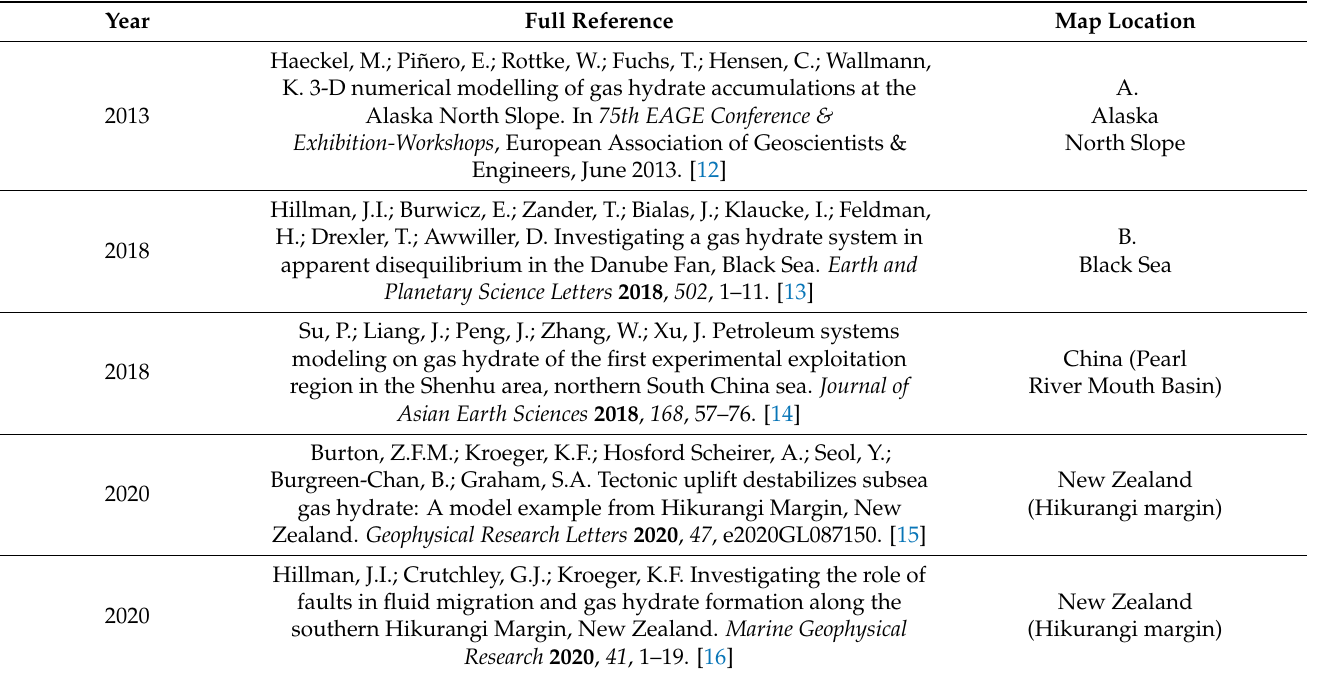
Figure 1. Study area locations for the surveyed gas hydrate modelling studies. Red circle indicates study with published TOC and HI values; yellow square indicates study that did not use or publish TOC and HI values. Numbering and lettering correspond to locations in Tables 1 and 2 (note that Table 2 Pearl River Mouth Basin and Hikurangi margin locations are not included in lettering for sake of visual clarity). Base map is from GeoMapApp v.2019. Table 2. Basic metadata of the modelling studies surveyed but lacking TOC and/or HI values.